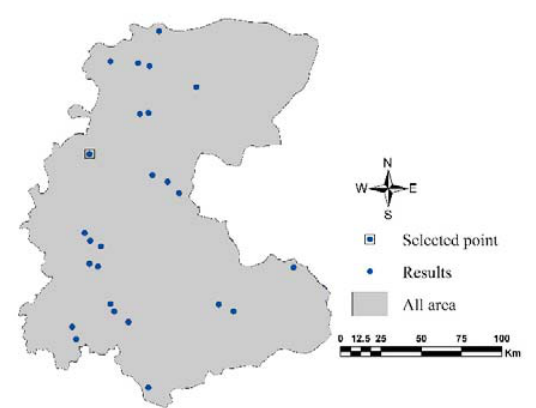
Fig. 9: Result of applying genetic algorithm